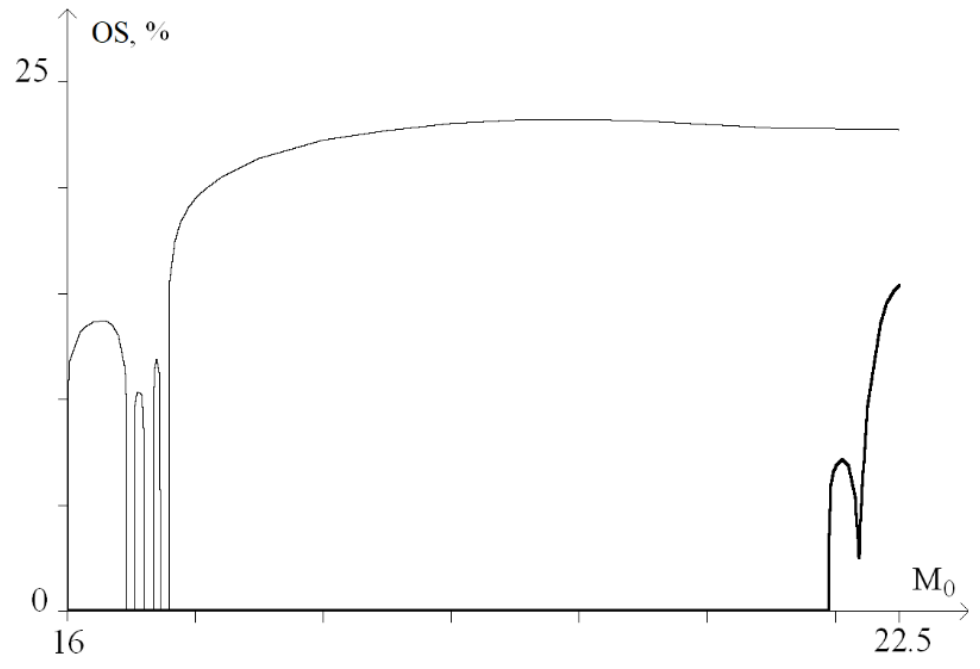
Figure 8. OS sections under the localized torque action ( M 0 : a — at M 0 = 22.2, b — at M 0 = 22.3) on bases 101 – 200. Green indicates OS in A – T pairs, red, in G – C pairs.